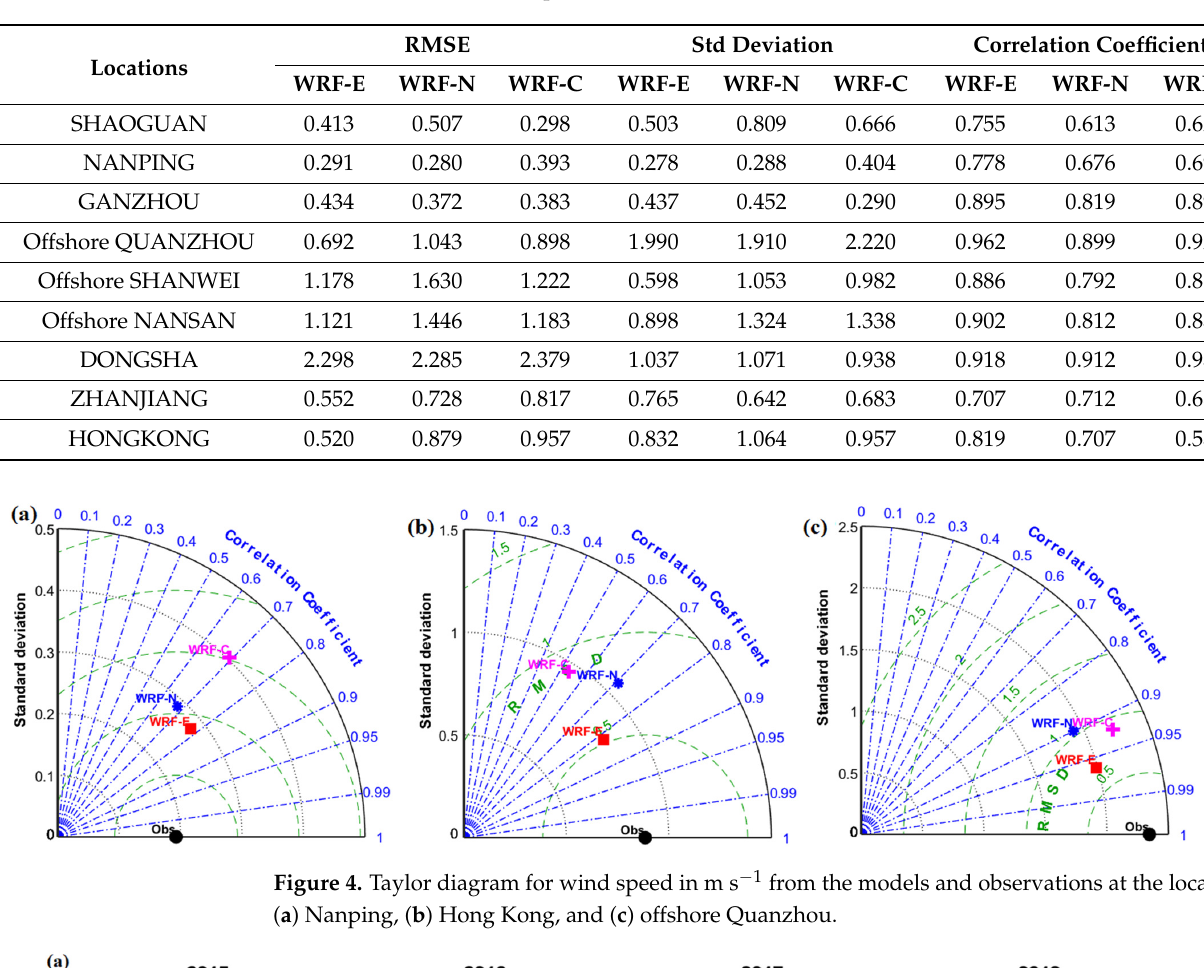
Table 2. Statistics of wind speed at different locations.